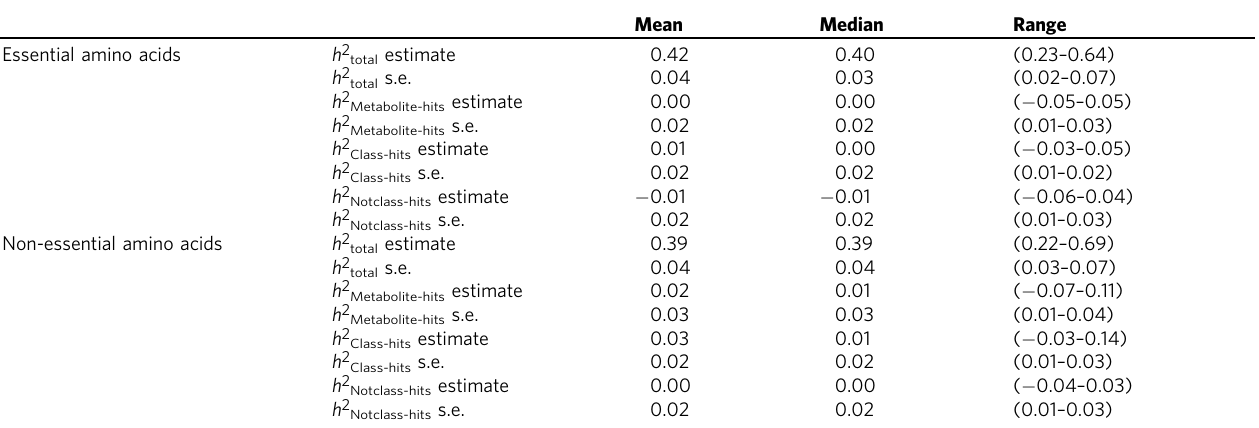
Table 4 Summary of the heritability estimates for the essential and nonessential amino acids.